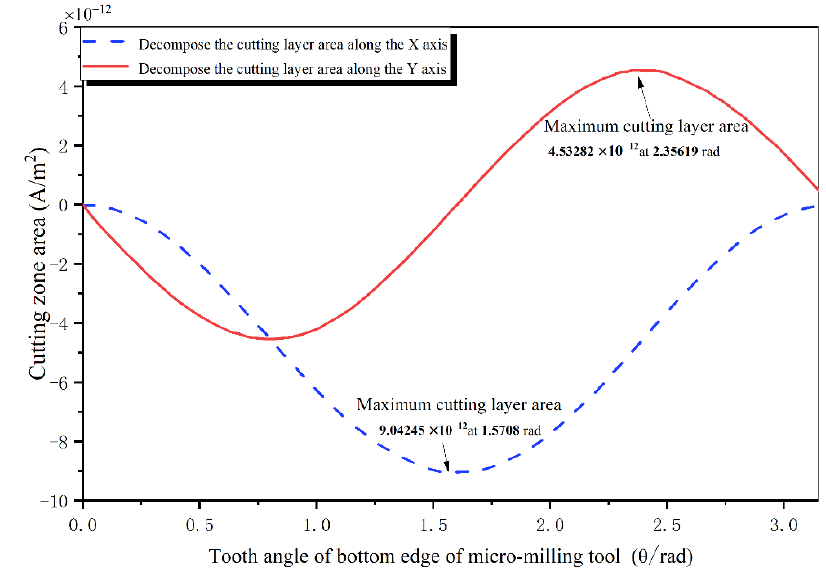
Figure 15. Decomposition of cutting layer area to coordinate axes.